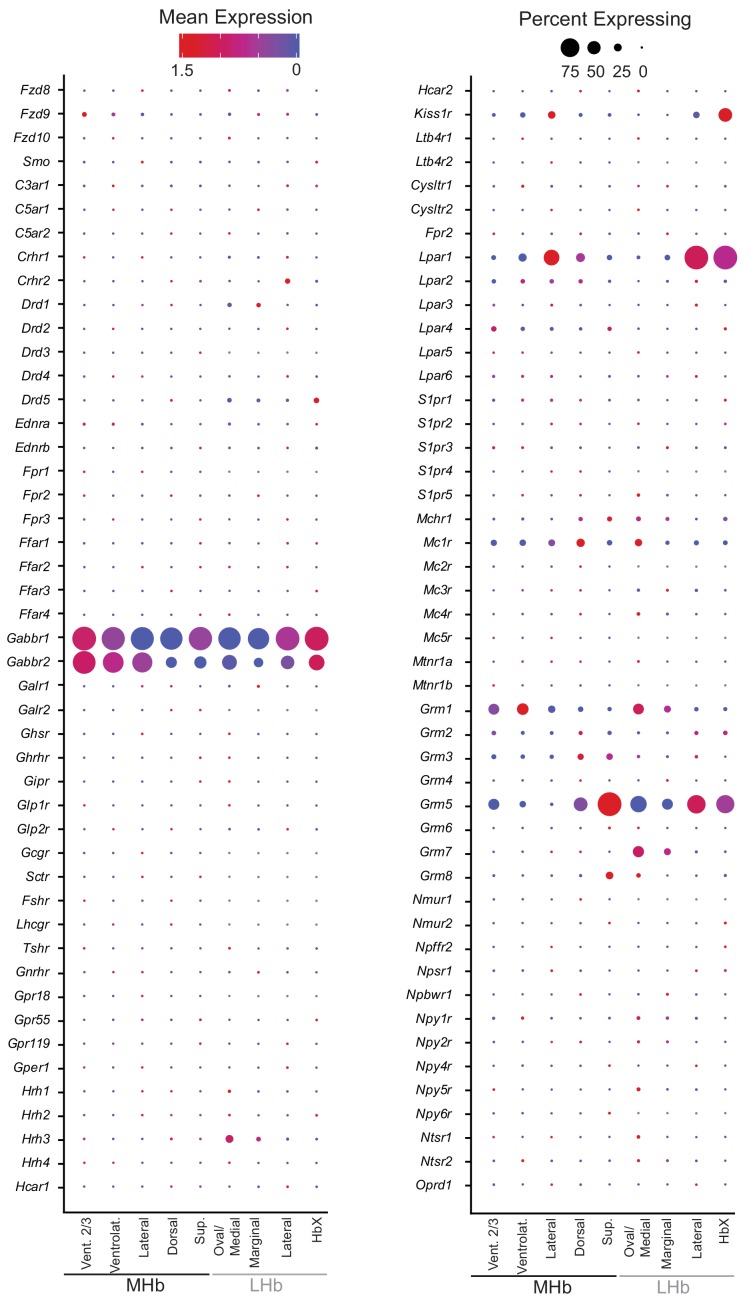
GPCR diversity in MHb and LHb neuronal subtypes (part 3).Dot plot displaying gene expression of all GPCRs detected in MHb and LHb neurons (Harding et al., 2018; Regard et al., 2008). Genes are grouped and listed alphabetically by receptor family name (Adenosine Receptors, Somatostatin Receptors, etc.). The color of each dot (blue to red) indicates the relative expression of each gene whereas the dot size indicates the fraction of cells expressing the gene.